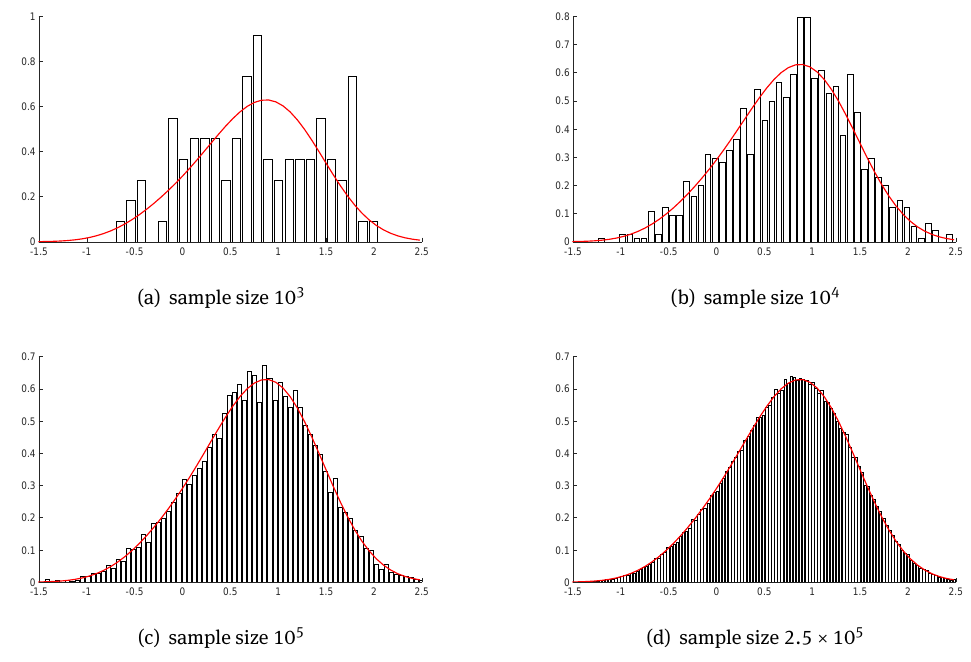
Figure 3: Maximum pdf f 3:3 and histogram for p = 3 , increasing sample sizes and dg g (3)